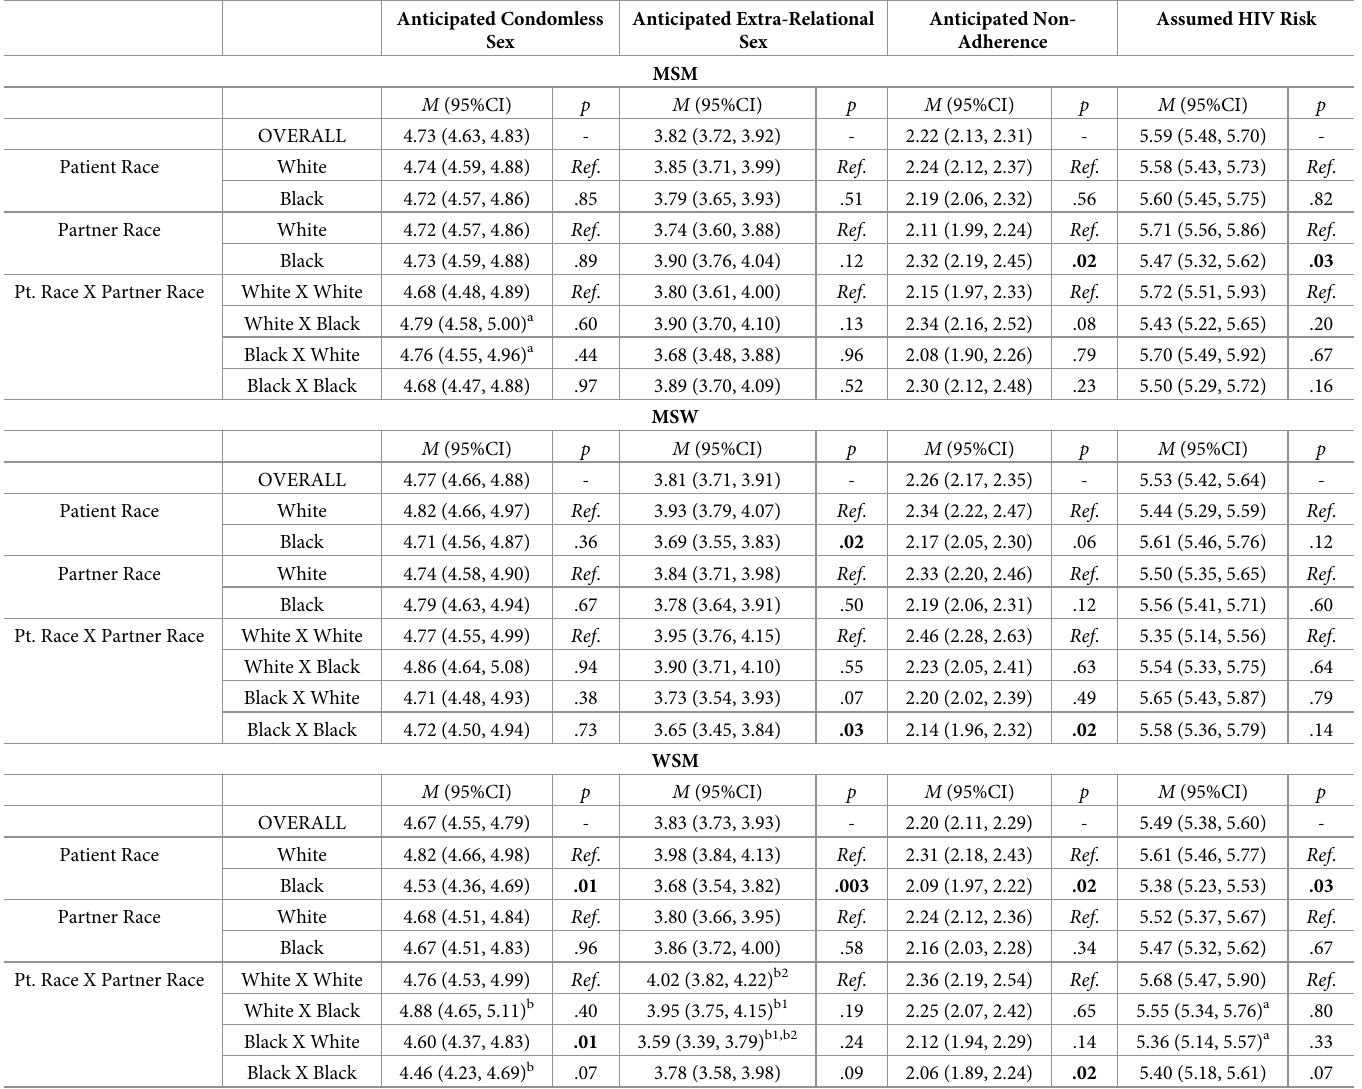
Table 2. Main effects of patient and partner race on